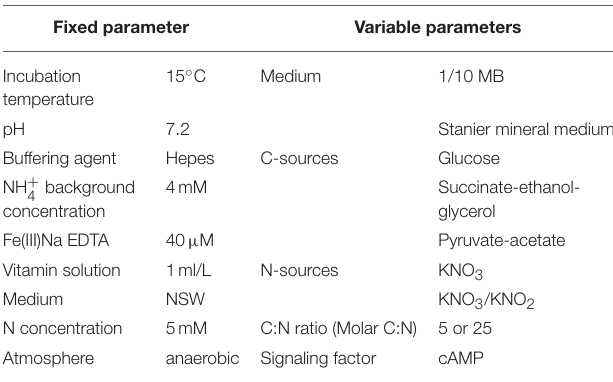
TABLE 1 | Fixed and variable parameters of the growth